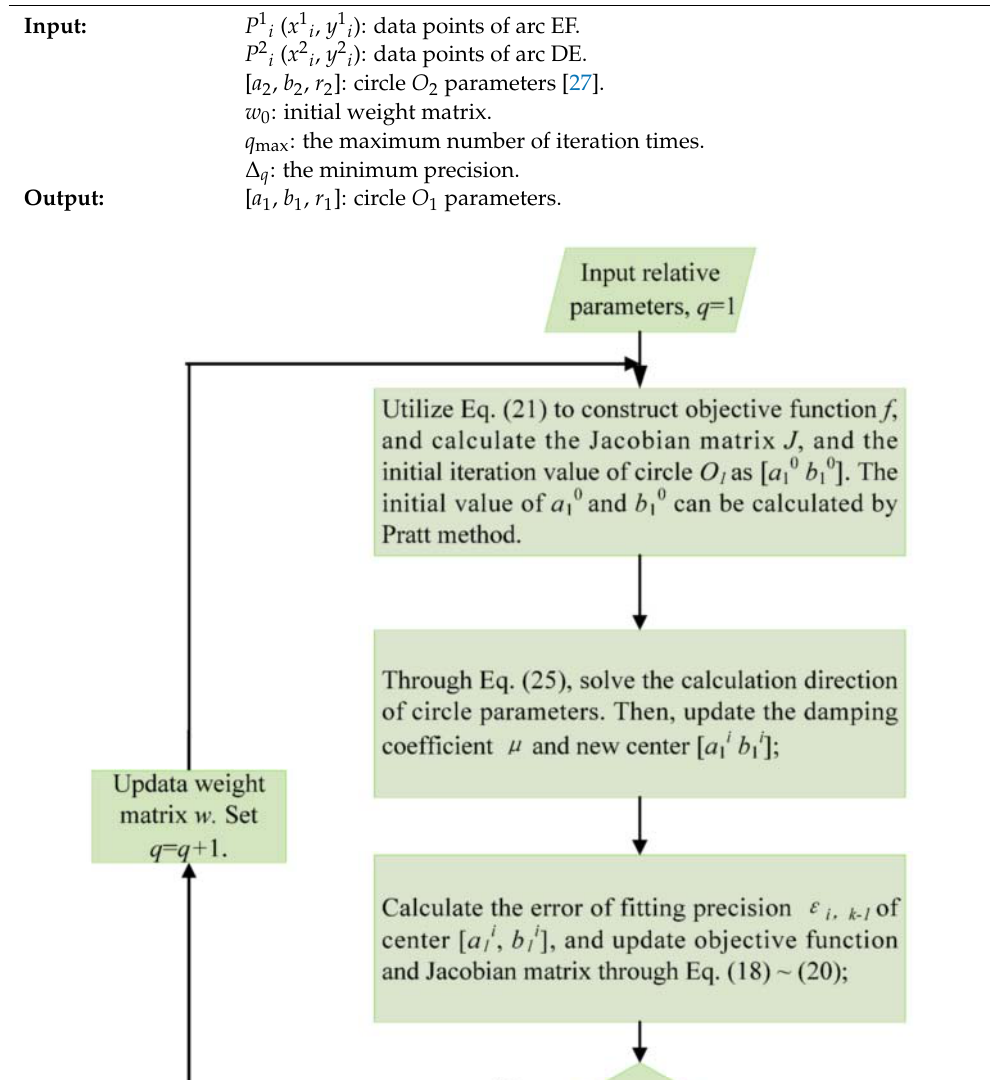
Algorithm 2. Two-Arcs Tangency Constraint (TATC)